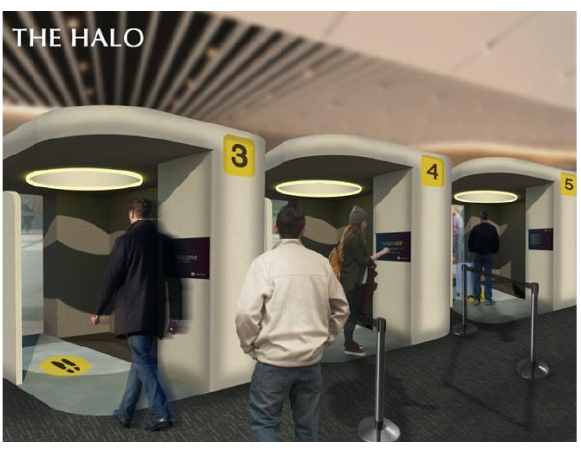
Fig. 4 . Student project outcome example: the Halo , a future airport screening system for elicit and biohazardous